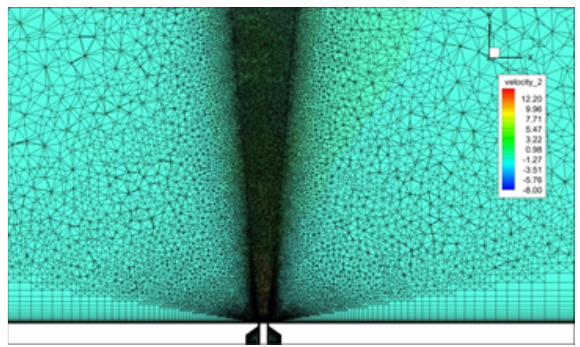
Fig. 2. Computational mesh - T1 variant